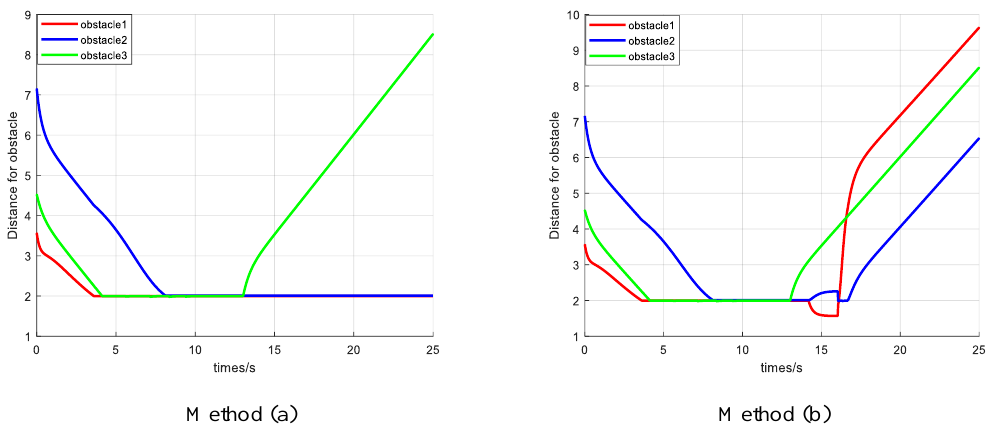
Figure 5. The figure shows the distance between the UGV and the obstacle in method (a) and method